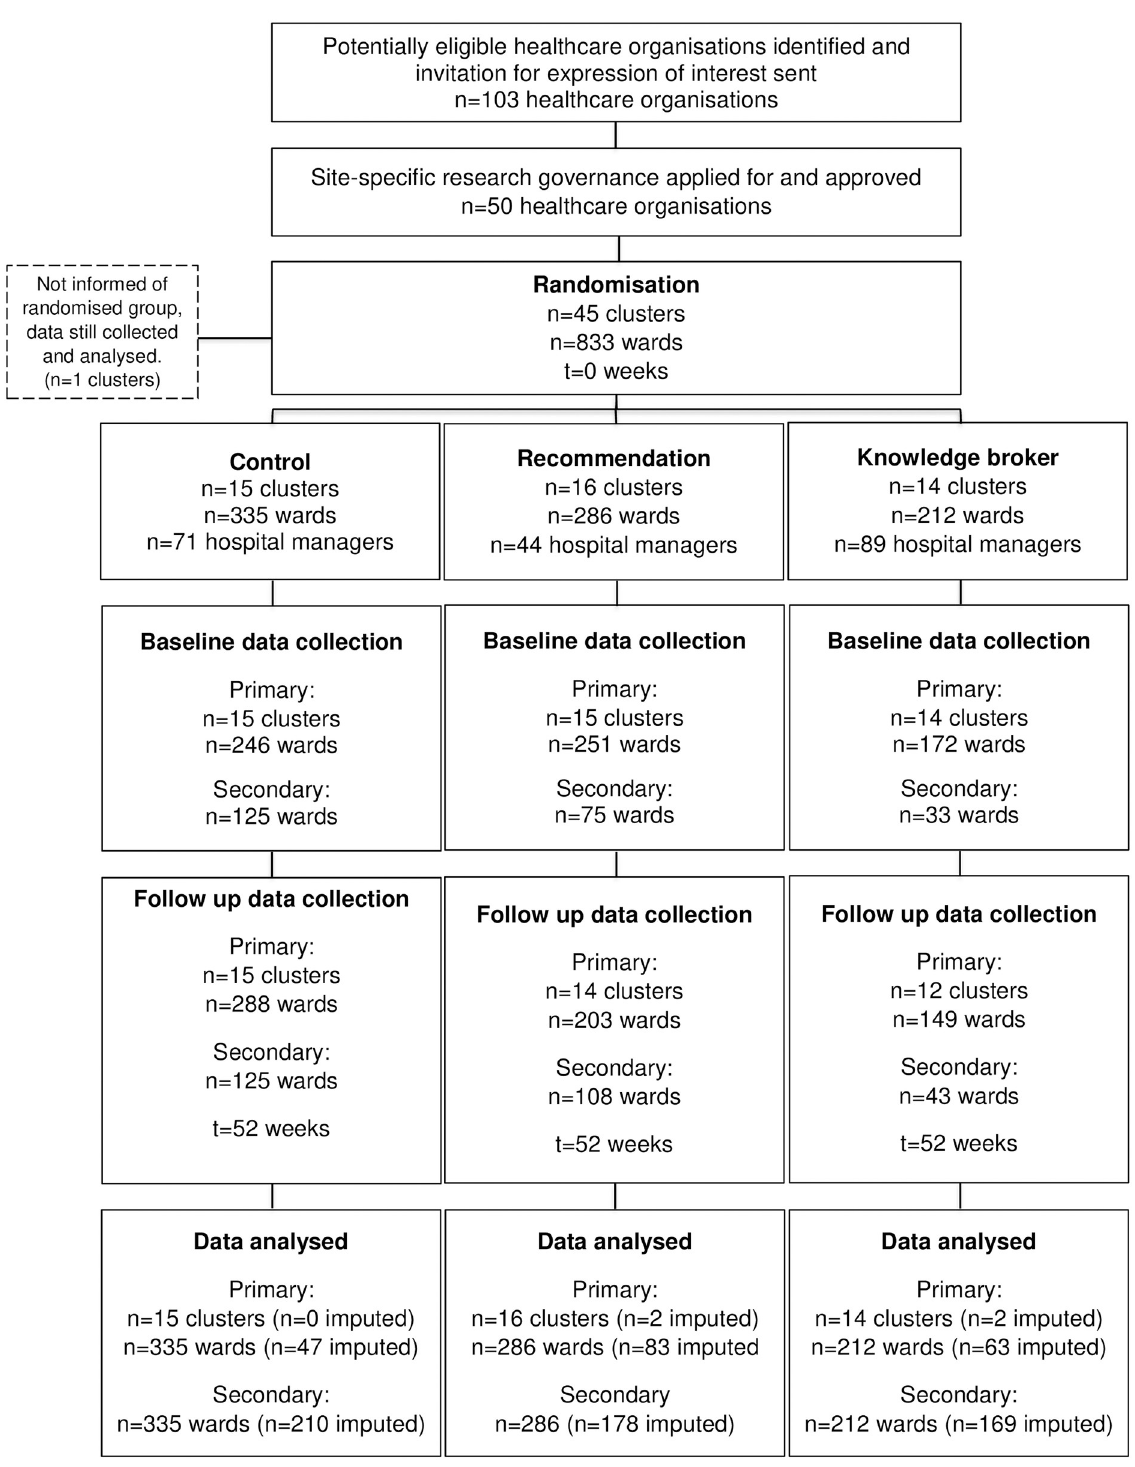
Fig 1. CONSORT study flow diagram. One cluster did not provide baseline or follow-up data; three clusters did not provide follow-up data only.